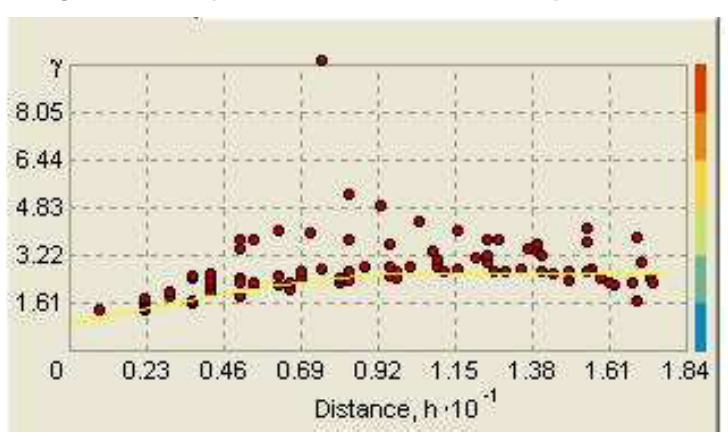
Figure 7. The graph of spherical semivariogram